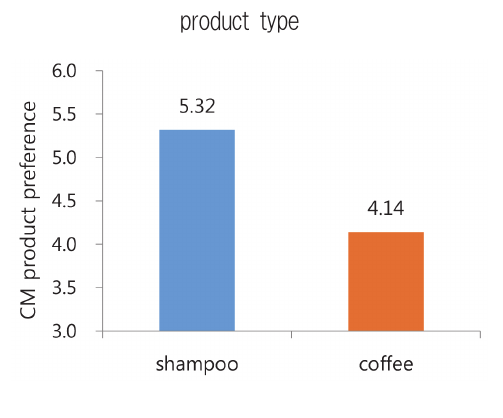
<Figure 1> Consumer preference for CM product by product